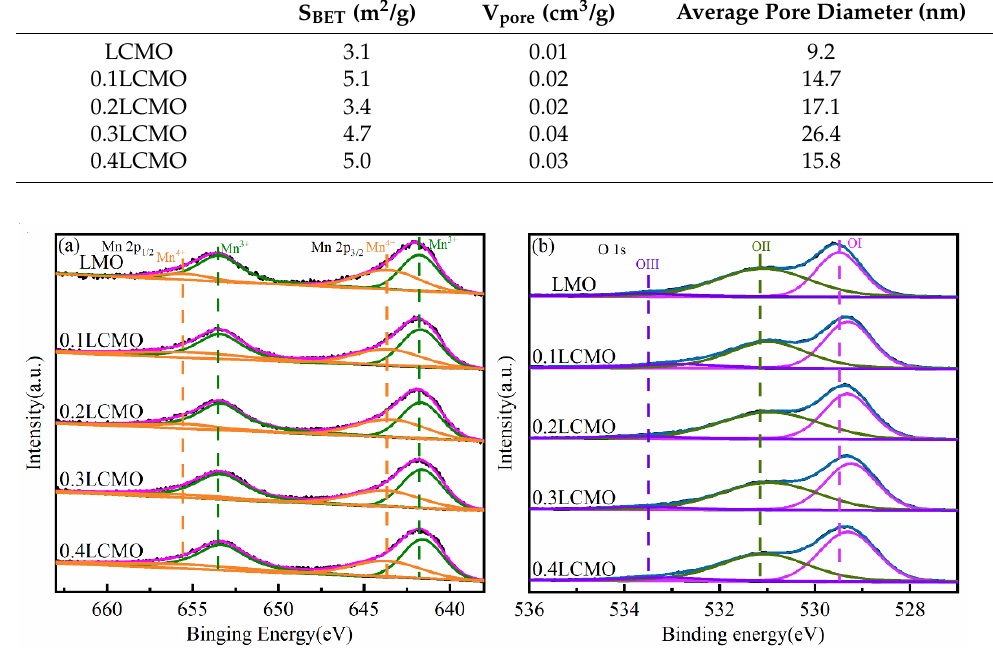
Figure 4. XPS spectra for Mn2p ( a ) and O1s ( b ) of the fresh samples.